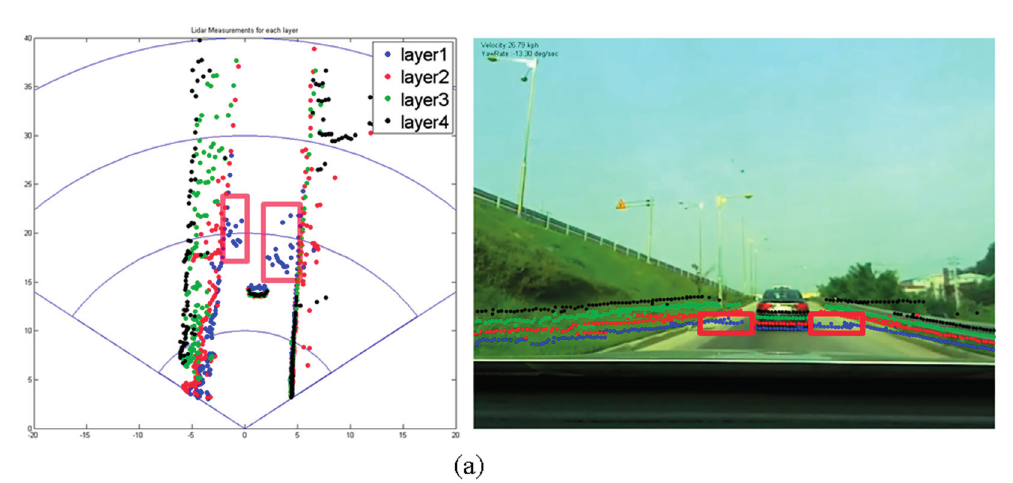
Figure 7. Ghost detection caused by reflection from the ground surface. ( a ) uphill road ( b ) flat